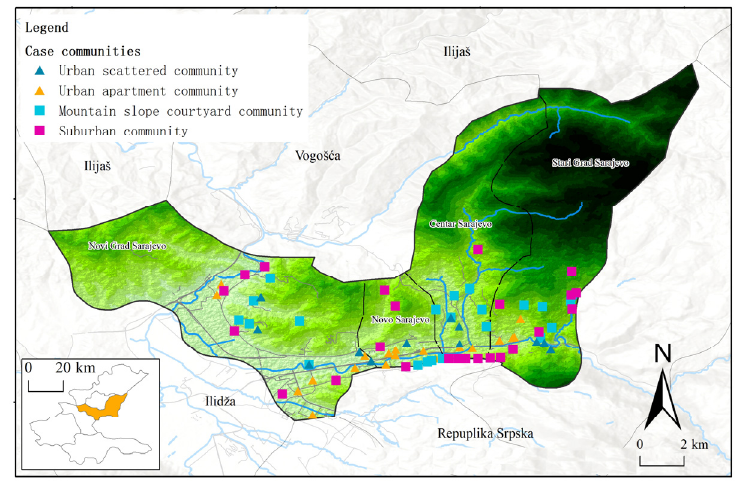
Figure 2. Case community distribution map of Sarajevo.